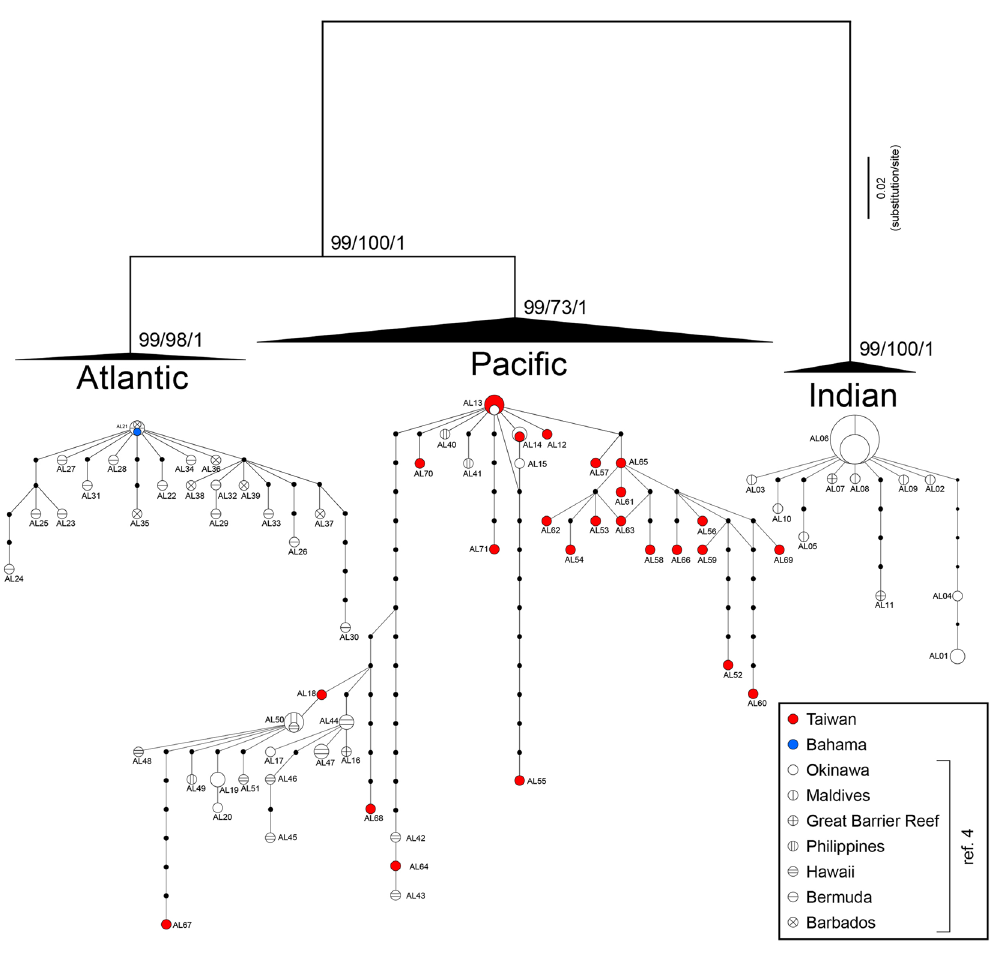
Figure 4. Genetic relationships of Asymmetron populations. Neighbour-joining, maximum likelihood, and Bayesian methods produced trees with the same topology for cytochrome c oxidase subunit I sequences (top) and show a close relationship between Pacific and Atlantic haplotype groups. Parsimony haplotype networks based on the same gene (bottom) show that haplotypes of all Taiwanese specimens are within the Pacific group. Sizes of circles indicate haplotype frequency and dots represent missing haplotypes.